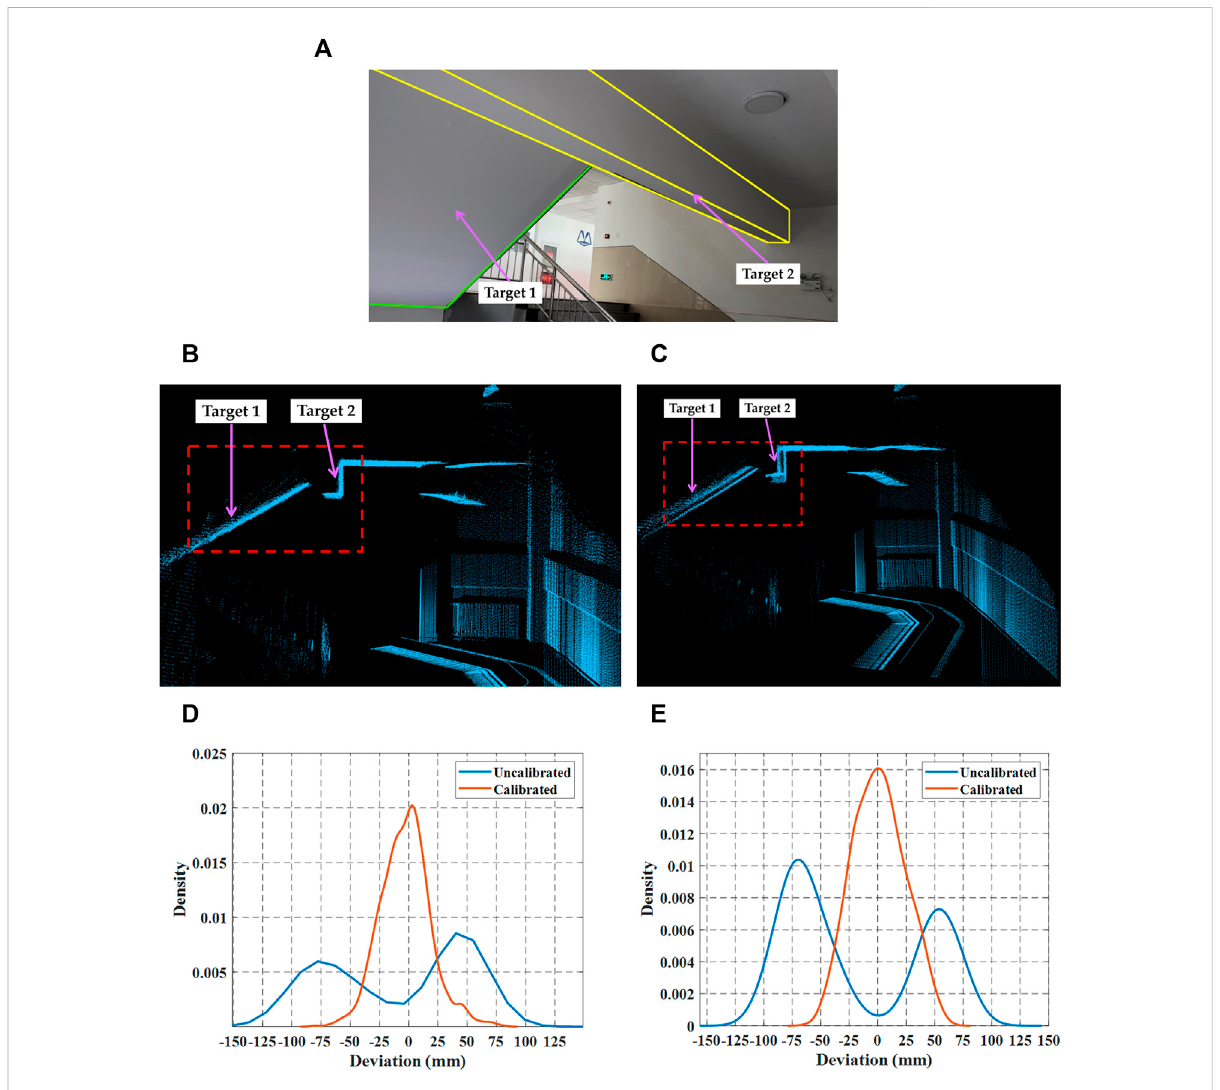
FIGURE 10 Deviation comparisons in a stairwell. The ladder plate and platform beam are used as the contrast objects, namely, Target one and Target 2 (A) the experiment scene: stairwell (B) target point cloud before calibration (C) target point cloud after calibration (D) deviation comparison of Target 1 (E) deviation comparison of Target